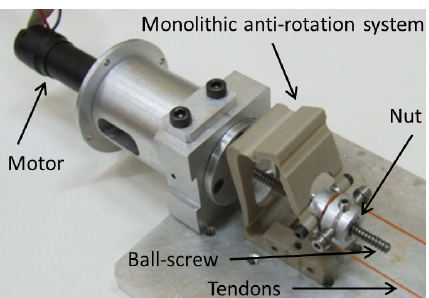
Figure 6. Partial view of the prototype, including its monolithic anti-rotation system.